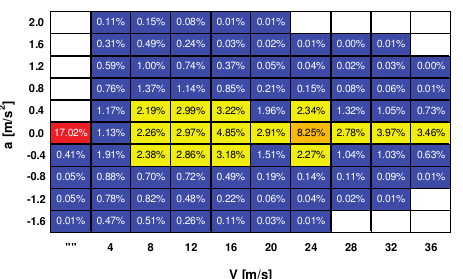
Fig. 9. Carbon monoxide road emissions and relative error for all complet- ed drives; invalidated drives are marked in red, while the parameter value range of valid drives (5–8) is marked in green